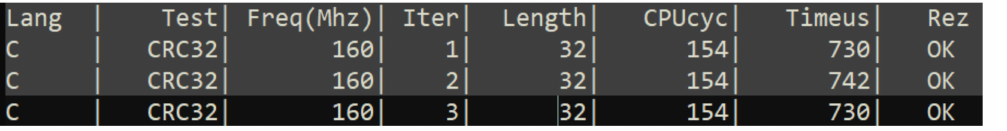
Figure 3. Test results for 3 iterations of CRC-32 in C programming language with data length of 32, displayed in a serial